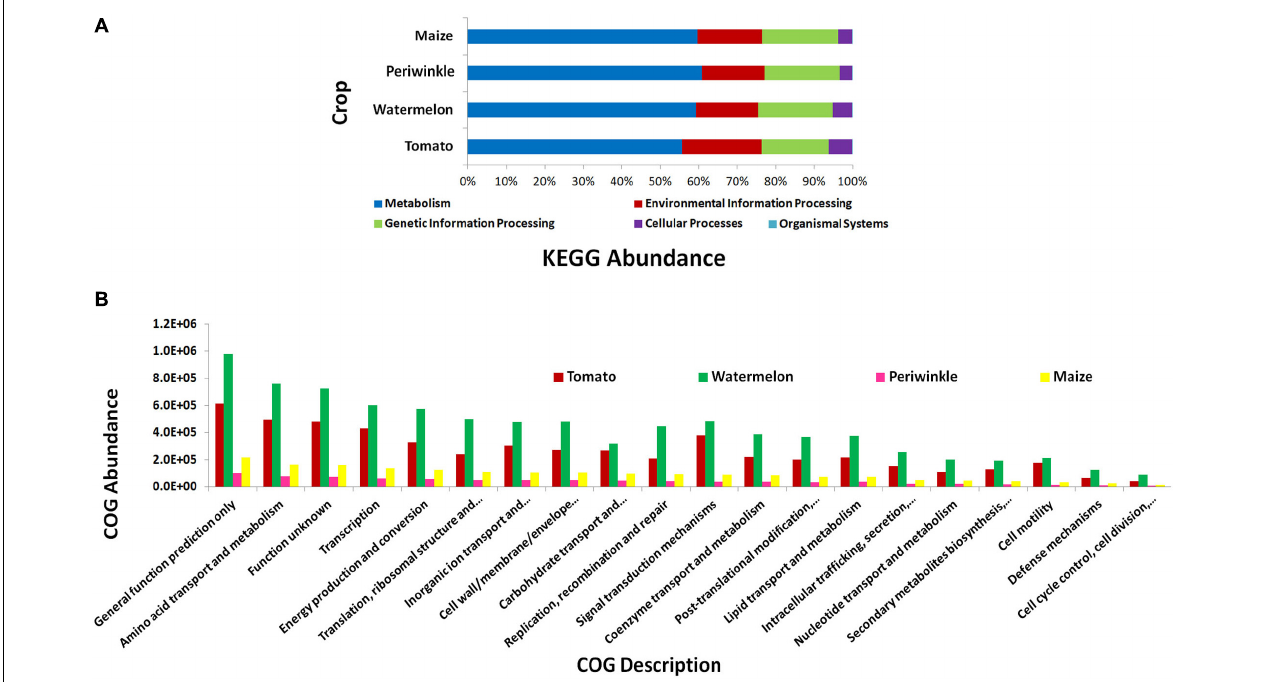
FIGURE 3 | PICRUSt functional analysis on 16S rRNA V3–V4 region profiles with Illumina MiSeq NGS platform on different plant species, tomato, watermelon, periwinkle/ Catharanthus , and maize. (A) KEGG Level 1 functional analysis and (B) COG Level 1